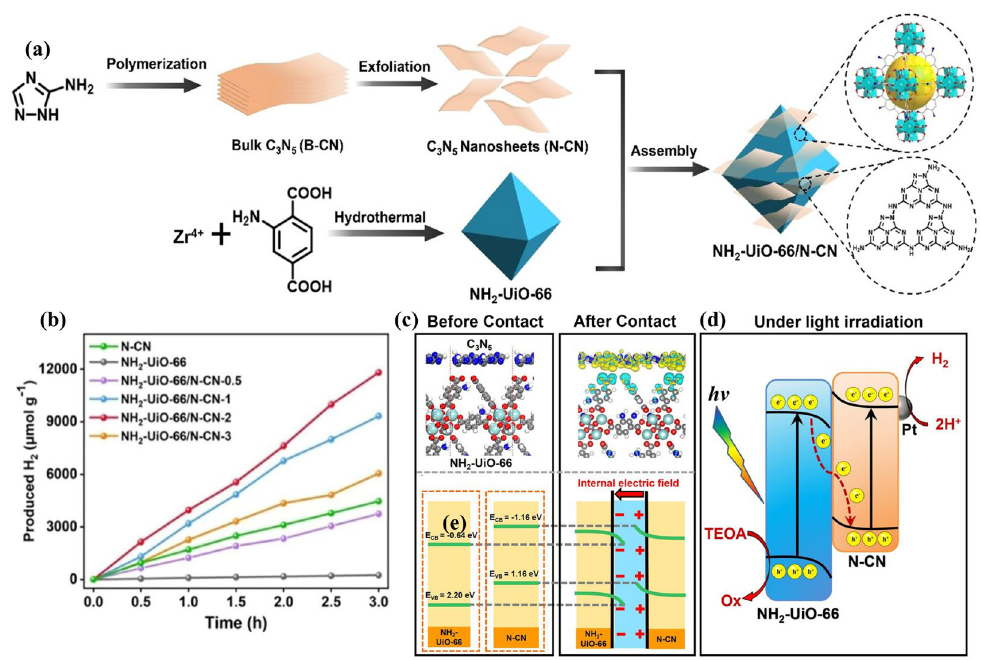
Figure 13. NH 2 -UiO-66/N-CN Z-scheme Heterojunction: ( a ) synthetic routes; ( b ) photocatalytic H 2 production amounts; ( c ) charge density differences and energy-level diagrams; ( d ) the proposed Z-scheme charge transfer mechanism. Adapted with permission from [52]. Copyright American Chemical Society,